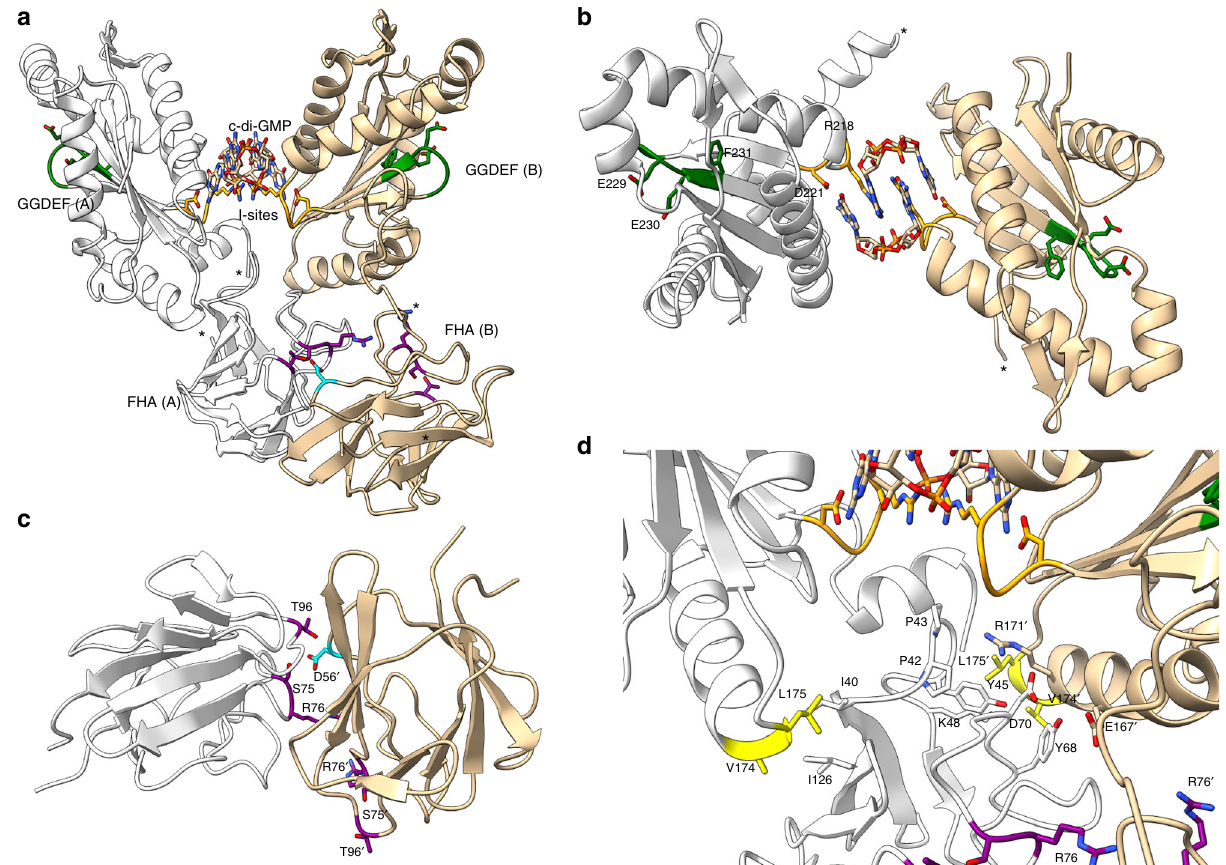
Fig. 1 Structure of full-length B. bacteriovorus DgcB (I site RxxD motif colored orange, active site GGEEF sequence green), with bound c-di-GMP located at interface of the two chains (A white, B tan, residue numbers in chain B given as prime). Residues in the FHA domain binding cleft are colored purple. a Juxtaposition of asymmetric FHA domains and GGDEF dimer, end of traceable regions denoted by sphere and asterisk symbol. b View 90 ˚ to that of a , demonstrating c-di-GMP intercalation at I-site of GGDEF dimer, holding the two active sites (green) antipodal to one another. c View from beneath GGDEF interface, showing FHA:FHA interaction and the projection of D56 (cyan) from chain B into the chain A FHA binding cleft. The two FHA domains are related by a ~90 ˚ rotation. d The chain A FHA domain is sandwiched by both protomers of the GGDEF dimer, particularly the helical turn residues V174 and L175 (colored